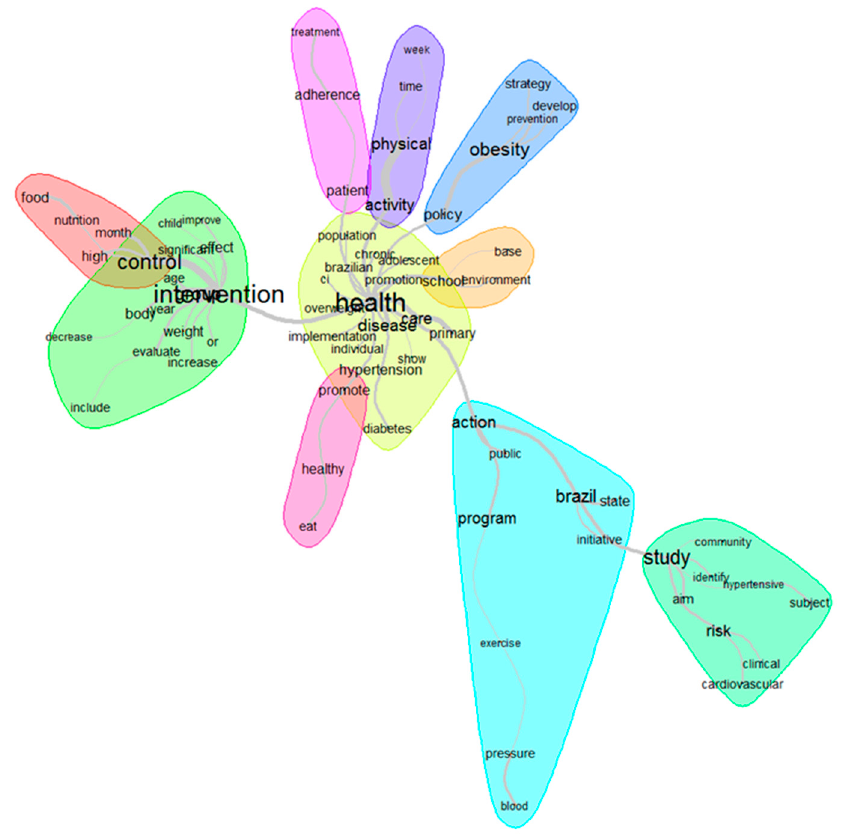
Figure 3. Analysis of similarity of studies. Source: Prepared by the authors using Iramuteq® soft- ware [35,79].